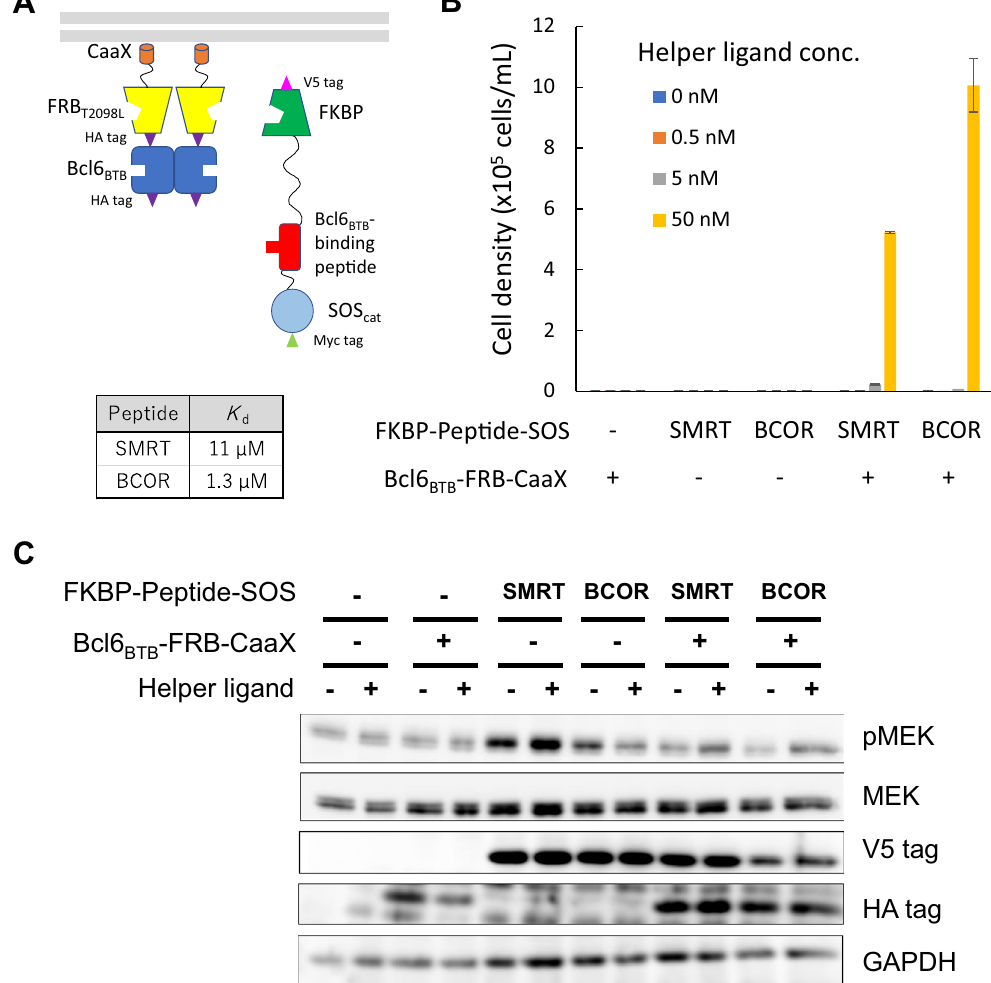
Figure 5. Detecting interactions between Bcl6 BTB and its binding peptides by H-SOLIS. ( A ) The design of the membrane-anchored and signaling chimeras incorporating Bcl6 BTB and its binding peptides. The dissociation constants of each peptide binding to Bcl6 BTB are also shown. ( B ) Cell growth assay. Cells were seeded at 1 × 10 5 cells/mL and cultured for 3 days in the medium with the indicated concentrations of the helper ligand AP21967. Viable cell densities are shown as mean ± SD (n = 3, biological replicates). ( C ) Signaling analysis. Cells were stimulated for 15 min with or without 50 nM of the helper ligand AP21967. Phospho-MEK, whole MEK, V5 tag (FKBP-Peptide-SOS expression), HA tag (Bcl6 BTB -FRB-CaaX expression), and GAPDH (loading control) were detected using corresponding primary antibodies. Uncropped blot images are provided in Supplementary Fig.